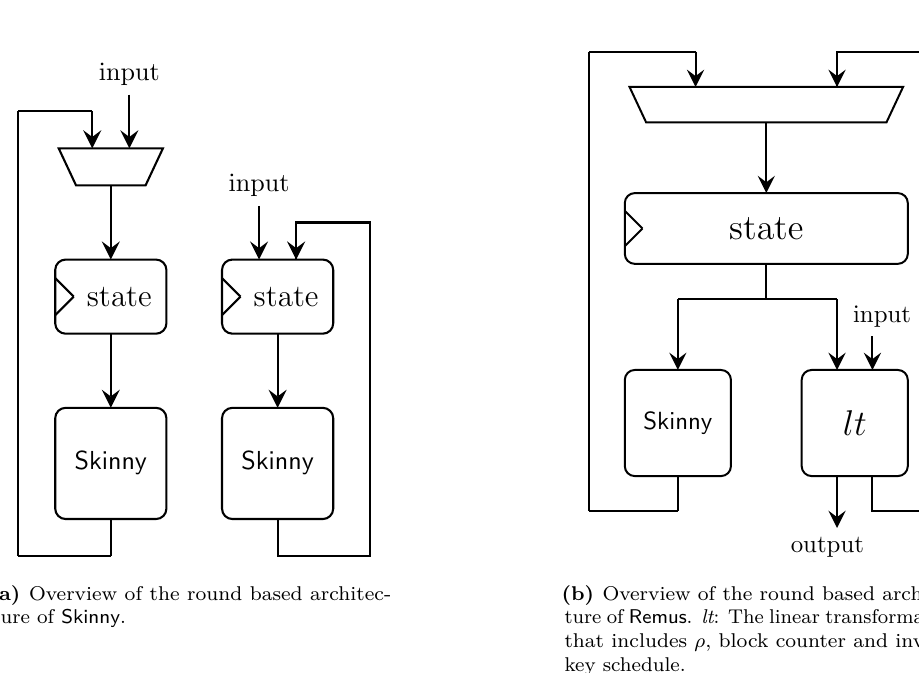
Figure 18: Expected architectures for Skinny and